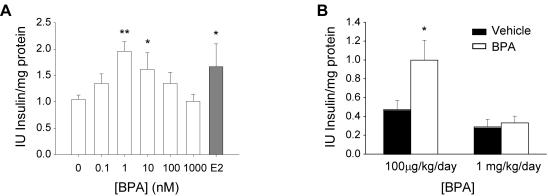
BPA action in vitro and in vivo.
(A) Insulin content of islets exposed to increasing doses of BPA for 48 hours, (n = 4, 7 mice), * p<0.05. (B) Insulin content of islets obtained from two sets of experiments. First group: vehicle (black column) and BPA 100 µg/kg/day (white column) treated mice for four days. Second group: vehicle (black column) and BPA 1 mg/kg/day (white column) treated mice for four days (from at least 3 mice), * p<0.05.